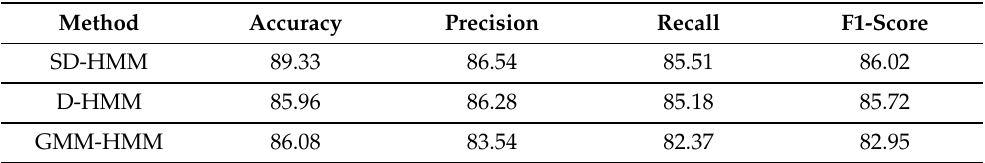
Table 3. Model performance evaluation results for the first dataset.